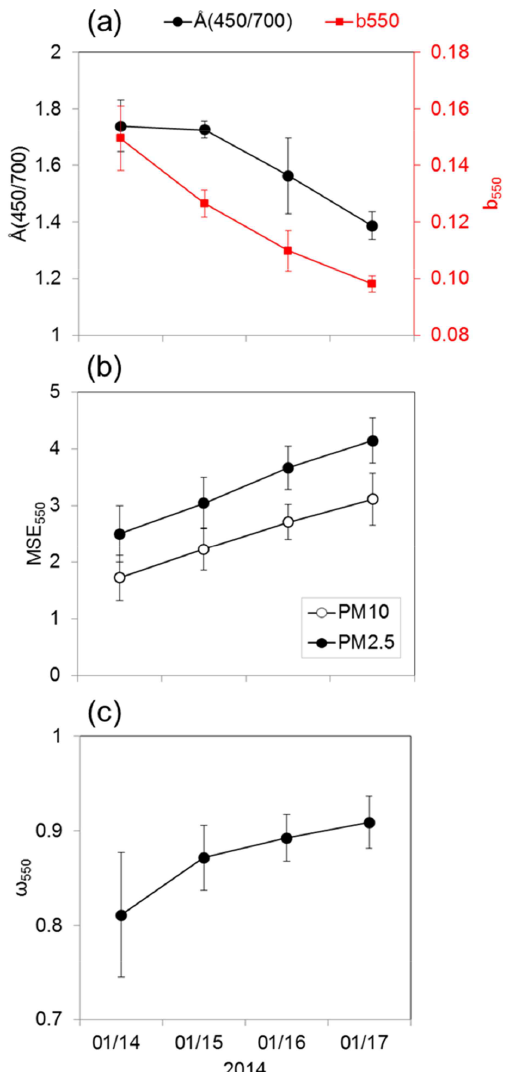
Figure 9. Temporal variations in (a) daily average Å (450 / 700) and b 550 , (b) mass scattering efficiency at 550nm (MSE 550 ) , and (c) ω 550 during 14–17 January 2014.